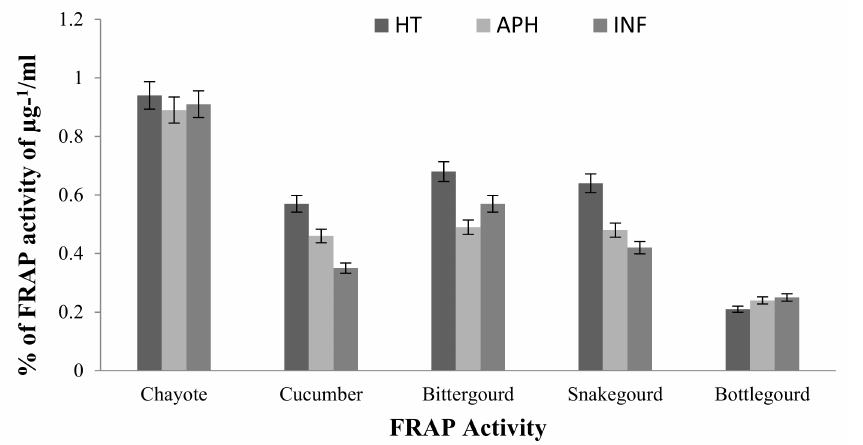
Figure 7. FRAP and superoxide anion antioxidant activity of healthy (HT), apparently healthy (APH), and infected (INF) cucurbit fruit tissues (bitter gourd, snake gourd, and bottle gourd) upon melon fly infestation. The vertical bars indicate the standard error. Significance at the p ≤